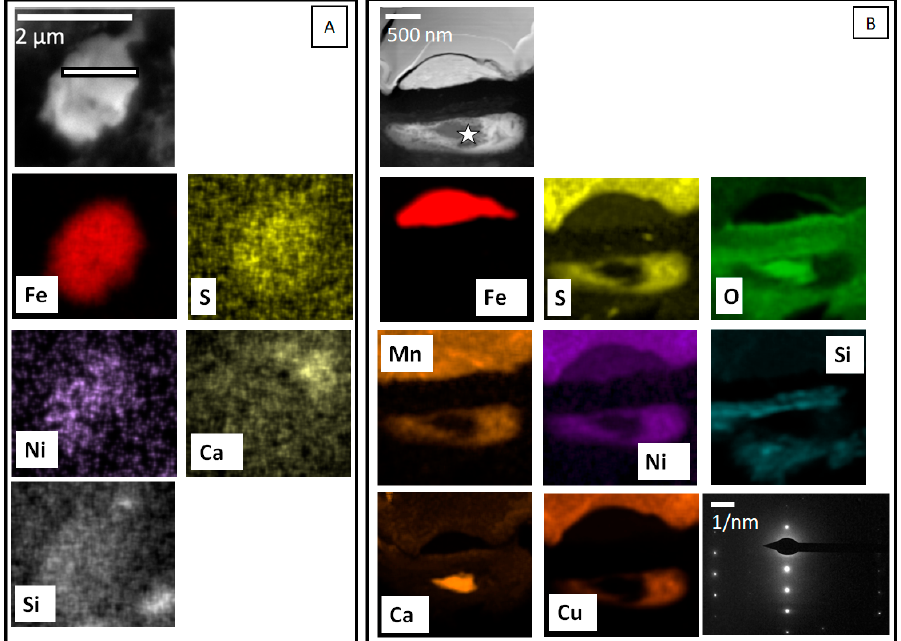
Figure 6. ( A ) SEM image and EDS element maps of a representative colloid soils developing on historic coal mine spoil; the white line represents the site of FIB section extraction; ( B ) TEM image of the extracted FIB section with EDS element maps. The dashed line represents the boundary between the FIB section and the Pt, and the white line represents the contact between targeted colloid and surrounding material. The grain was identified as anorthite based on the ( − 1, − 7,1) reflection with a d ‐ spacing of 1.7813 Å.